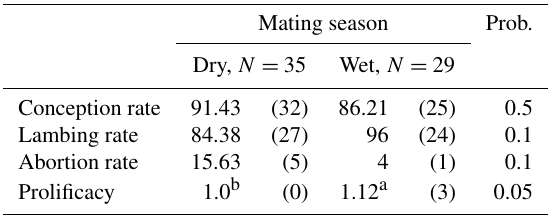
Table 4. Effect of dry and wet seasons on reproductive performance of Abou-Delik